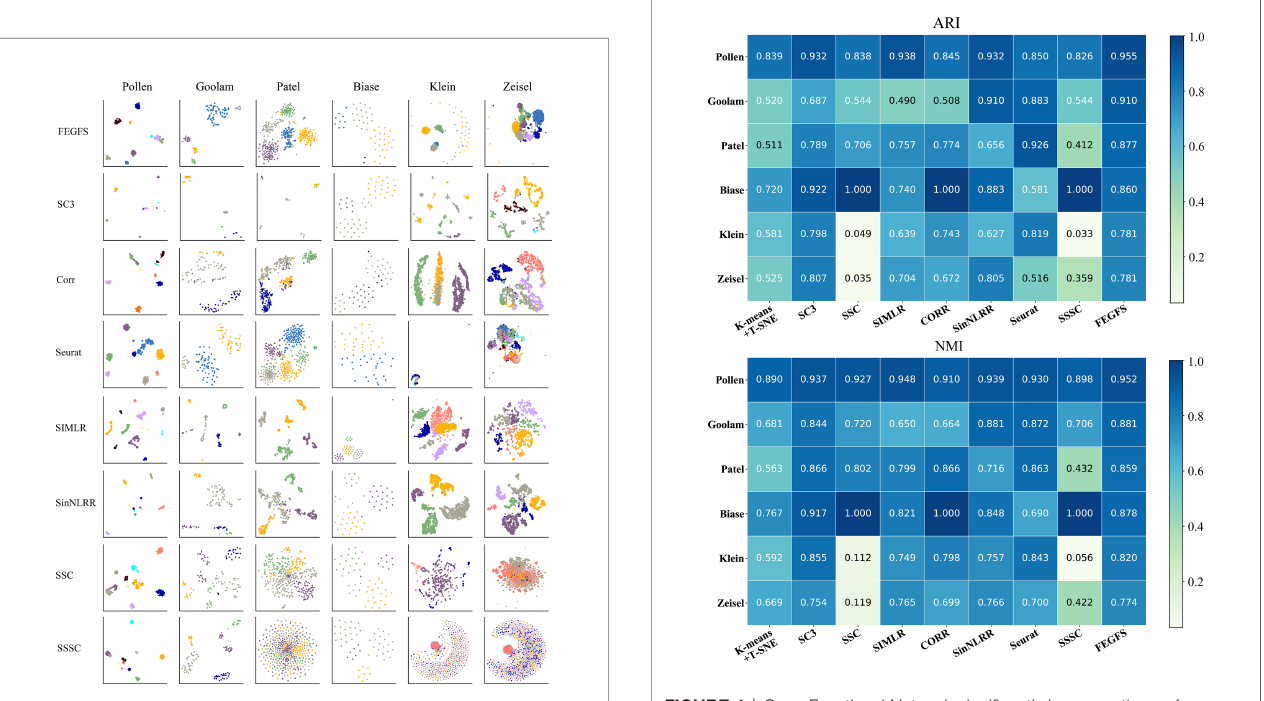
FIGURE 4 | Gene Functional Network signi fi cantly improves the performance of the existing cell type identi fi cation tool Agglomerative. The adjusted Rand index (ARI) and normalized mutual information (NMI) obtained by clustering on six scRNA-seq datasets using different cluster